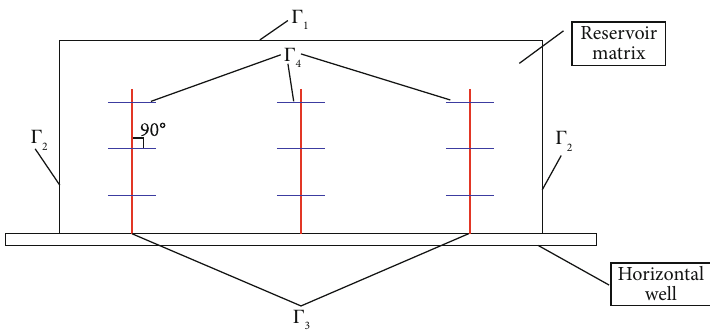
Figure 1: Double-porosity physical model. Γ